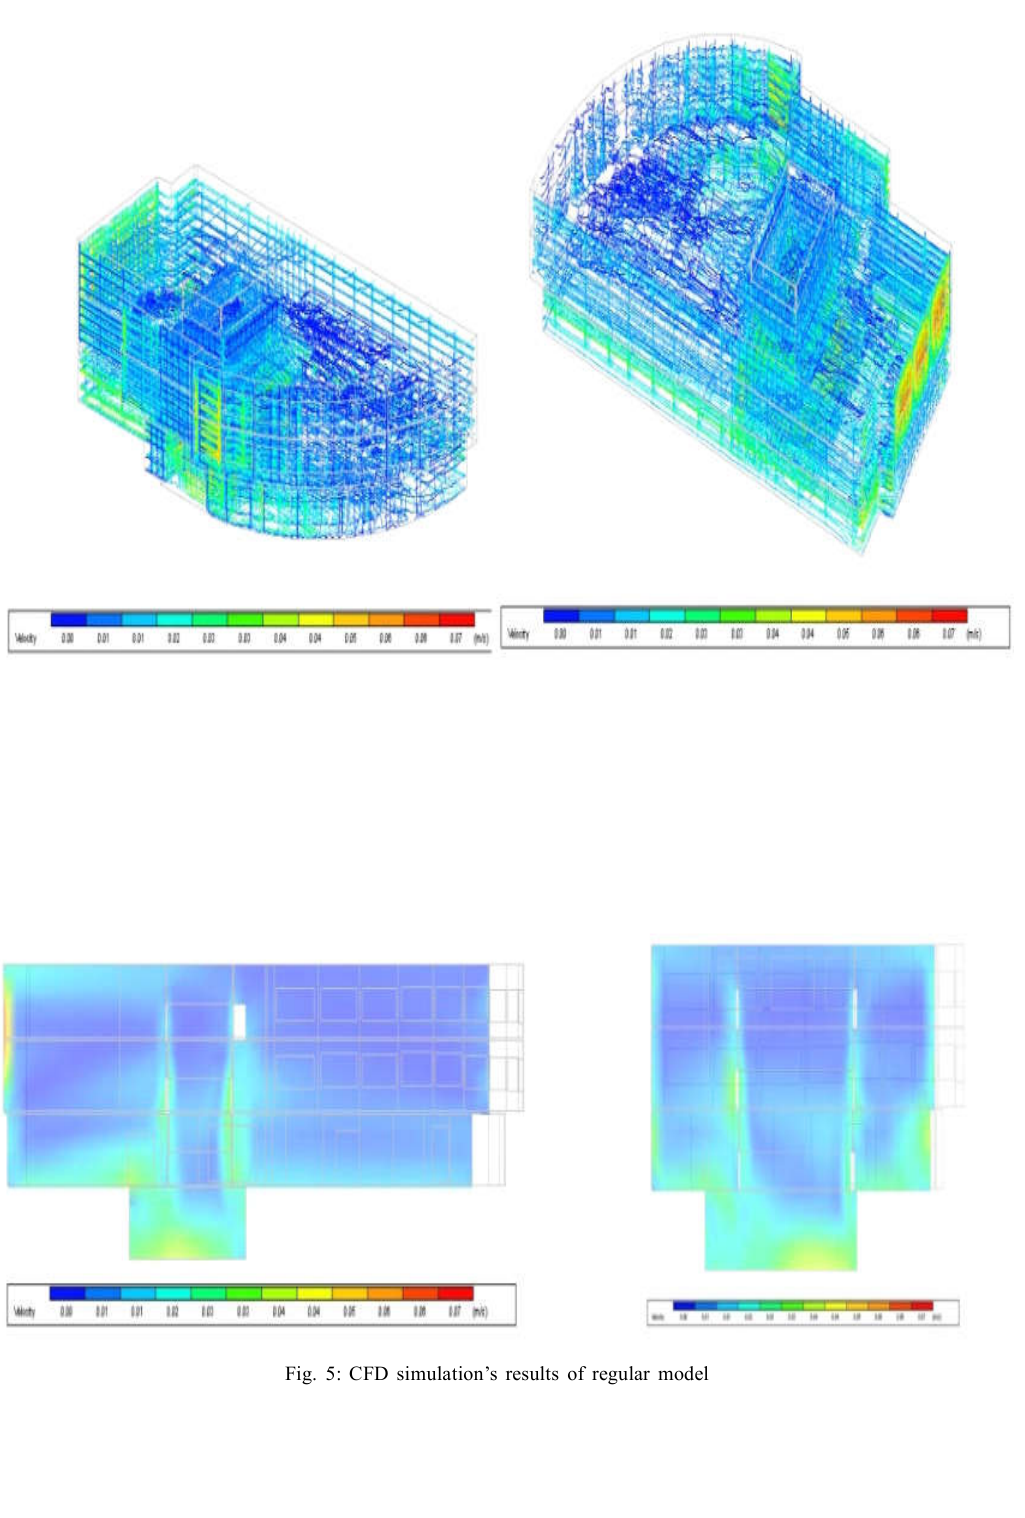
Fig. 5: CFD simulation’s results of regular